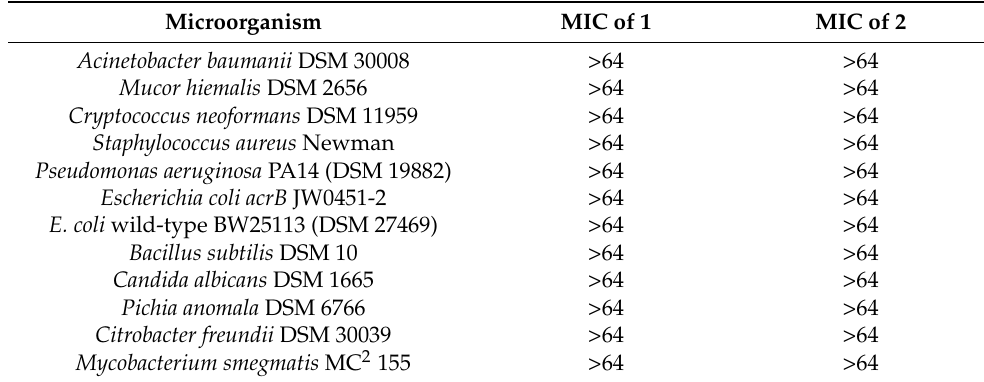
Table 1. Minimum inhibitory concentration (MIC) values ( µ g/mL) of Myxarylin and Myxarylin-Boc ( 1 and 2 ) against common microbial